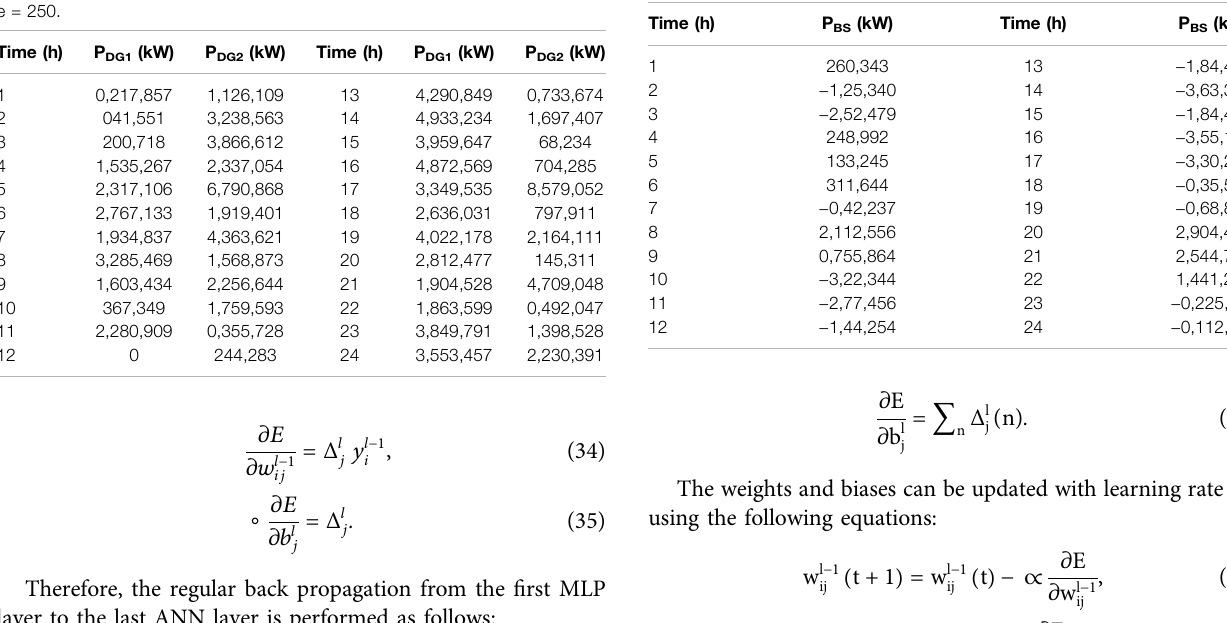
TABLE 5 | Battery produces optimal power using the ANN for e (cid:1) ( t ) using the ANN for i